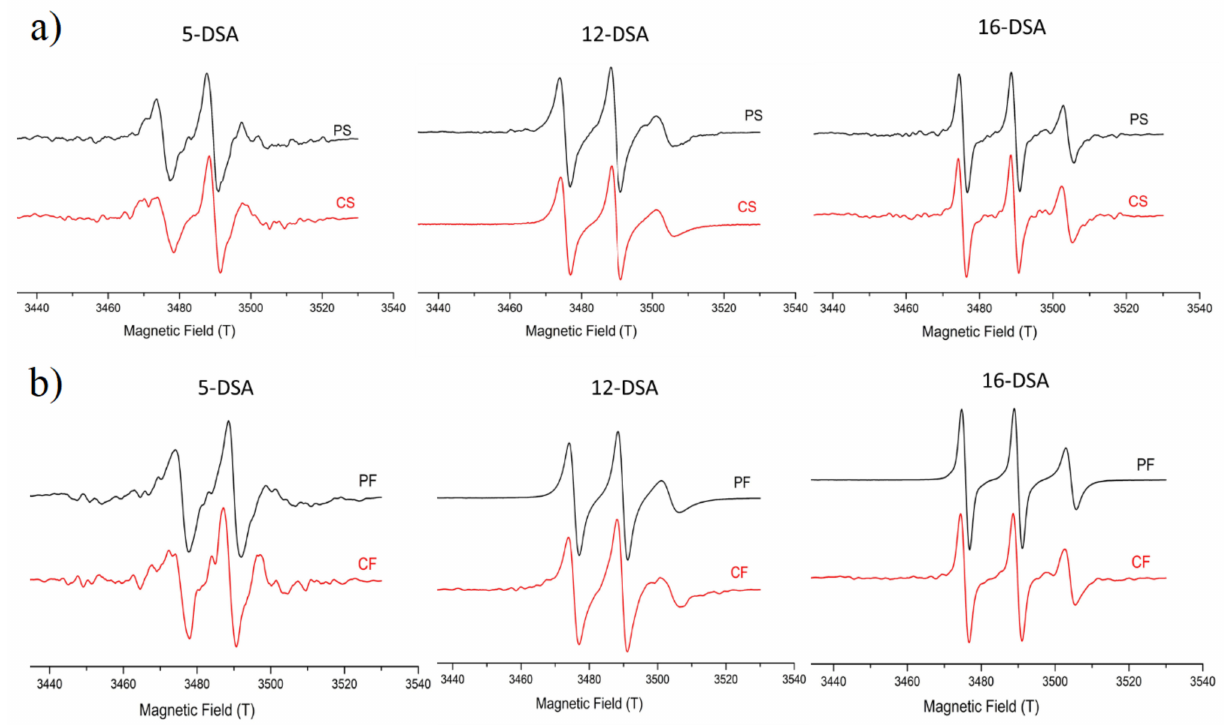
Figure 1. EPR spectra of the three spin-probes in ( a ) soybean and ( b ) fish oil NEs in the presence (red line) and absence (black line) of